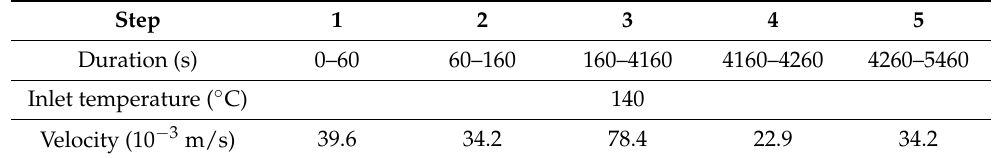
Table 2. Design parameters of regeneration